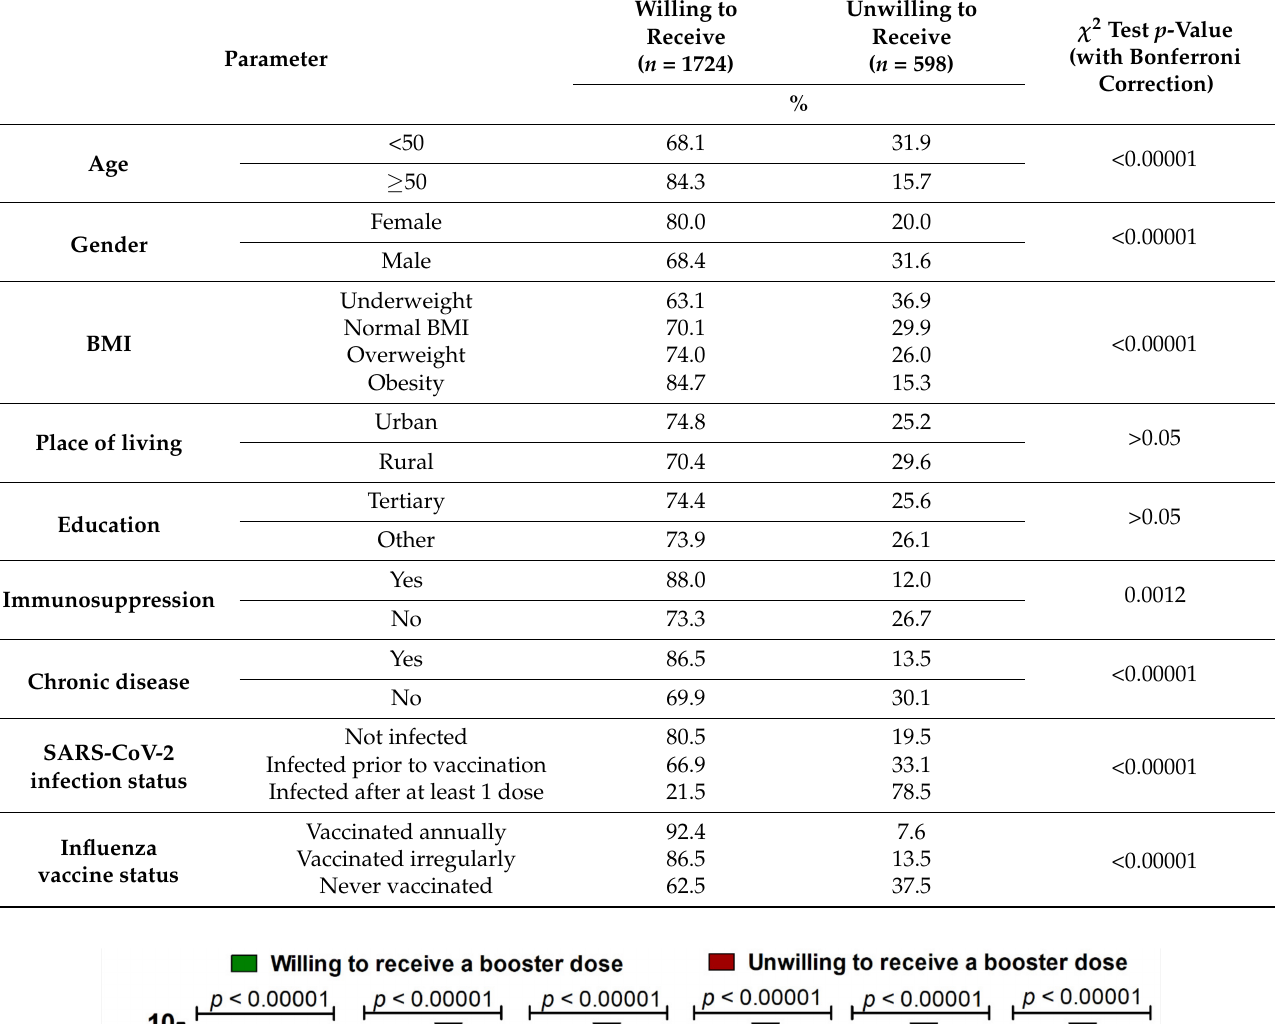
Table 2. The frequency of willingness and unwillingness to receive the potential booster COVID-19 vaccine dose in different demographical groups in the studied population ( n = 2322). Subjects who were unsure about receiving the booster dose were excluded from this analysis ( n = 105).